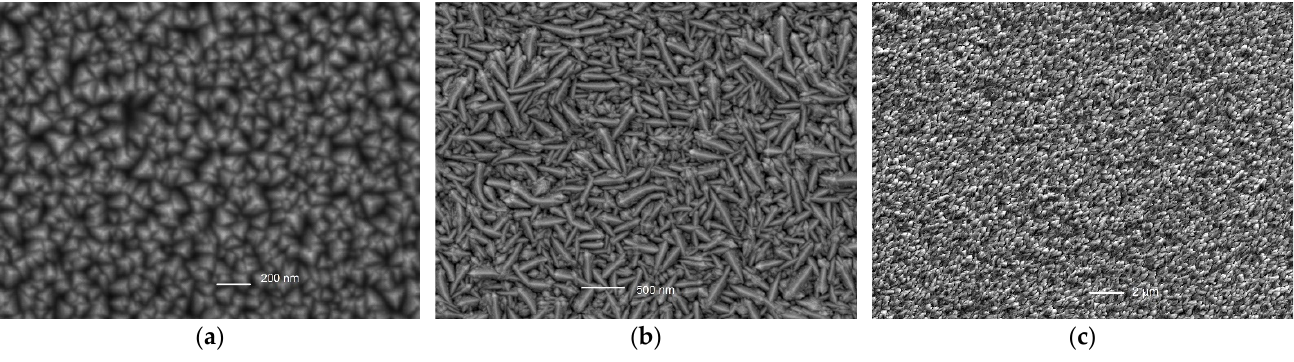
Figure 3. PVD nanostructure: ( a ) isotropic pyramid structure (diameter ~100 nm), ( b ) isotropic rod structure (diameter ~300 nm) and ( c ) anisotropic pyramid structure.